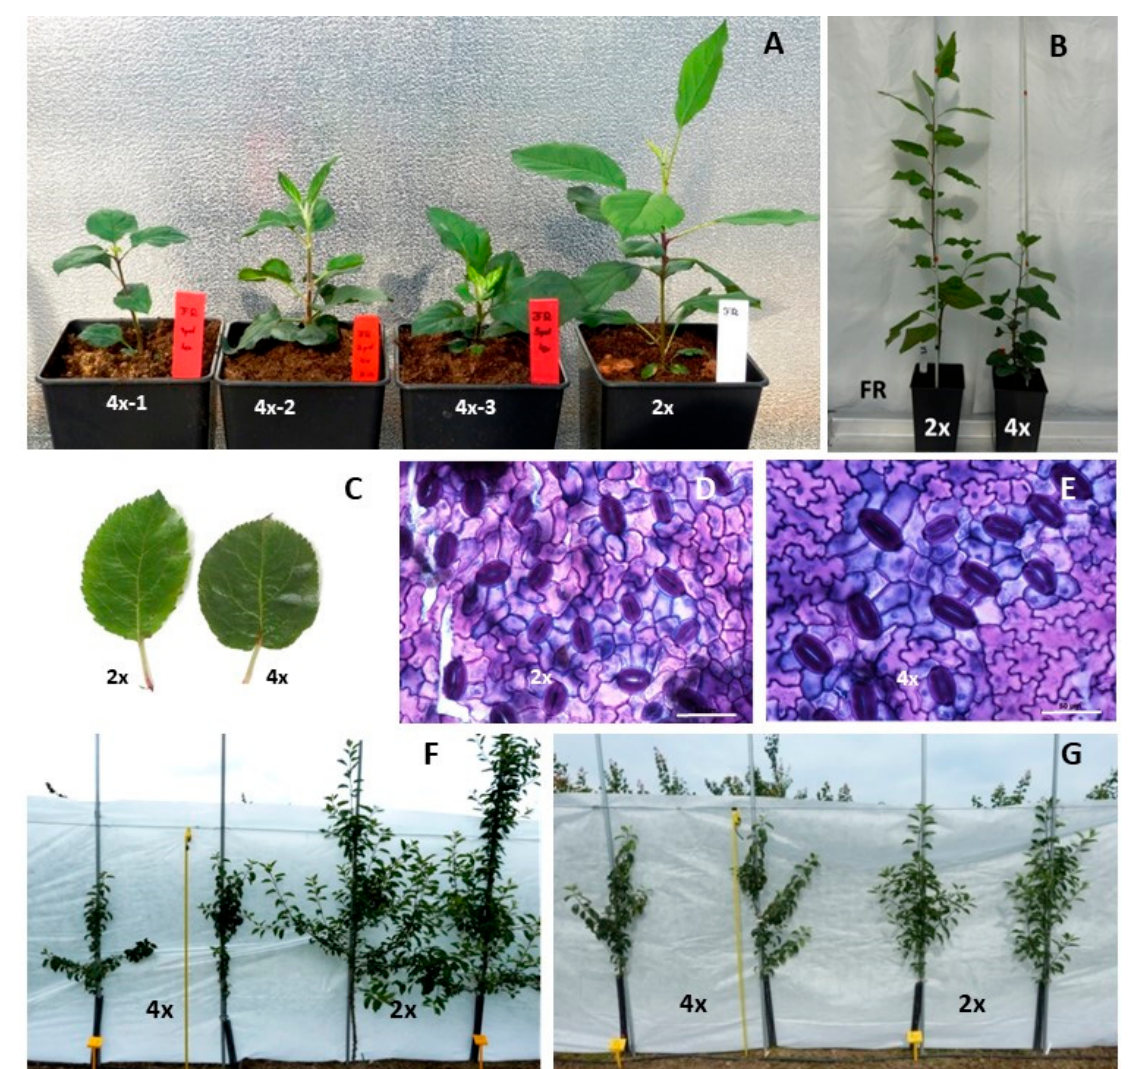
Figure 1. Phenotype of apple diploid and tetraploid plants of ‘Free Redstar’ cultivar: ( A ) three-month old and ( B ) six-month old own-rooted plants, ( C ) leaves and ( D , E ) stomata, ( F ) own-rooted and ( G ) M9-grafted three-year old plants growing in experimental orchard of The Research Institute of Horticulture (Skierniewice, Poland), bars represent 50 µm.